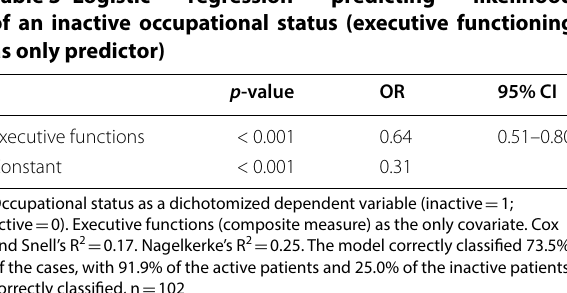
Table 3 Logistic regression predicting likelihood